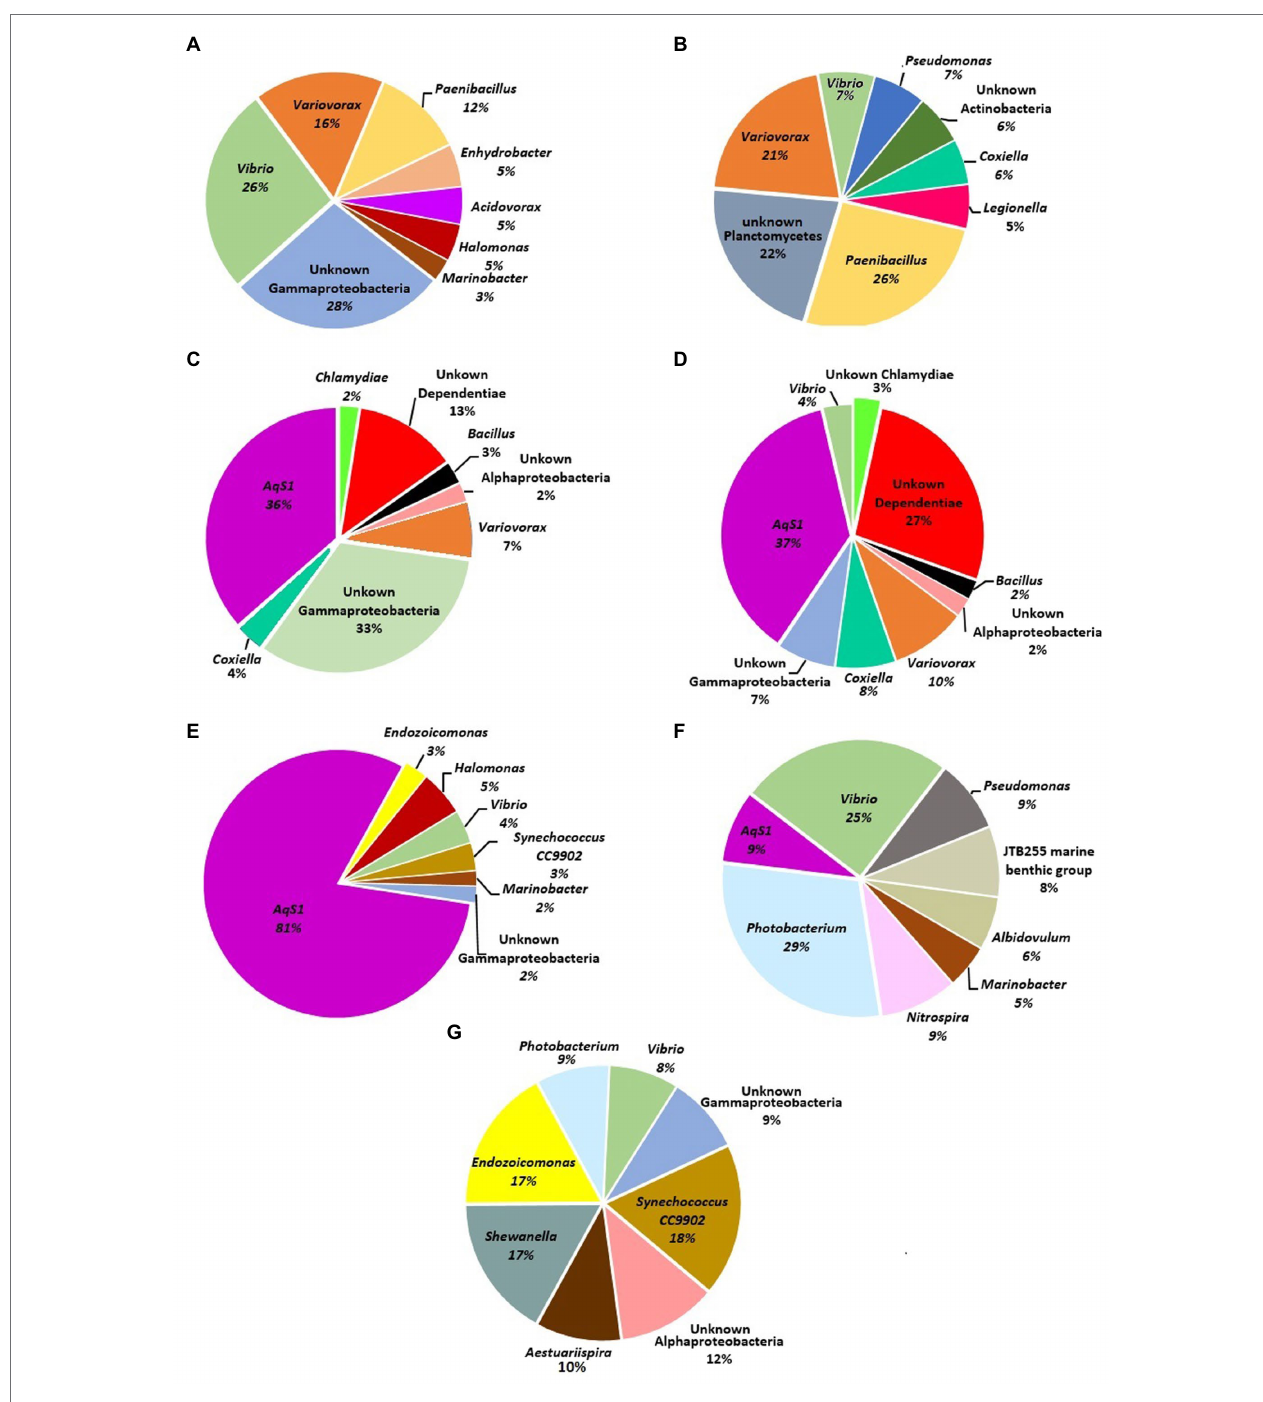
FIGURE 2 | Pie charts represent most dominant bacterial genera associated with sponge samples in the present study. (A) Haliclona sp. 1KI, (B) Haliclona sp. 5KI (C) Niphates sp.1 2NW, (D) Niphates sp.2 5NW, (E) Niphates sp.3 2KI, (F) Chondrilla australiensis 4KI, and (G) Amphimedon sp.